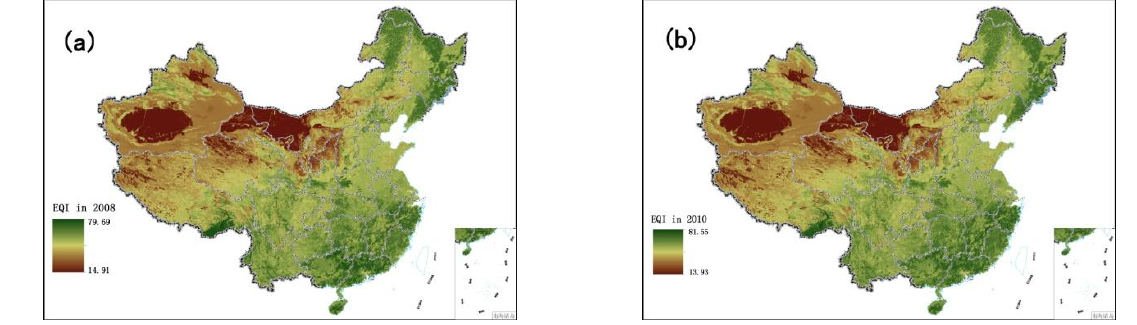
Figure 2. Ecological quality of environment over the Chinese mainland in 2008 and 2010. ( a ) EQI in 2008; ( b ) EQI in 2010.